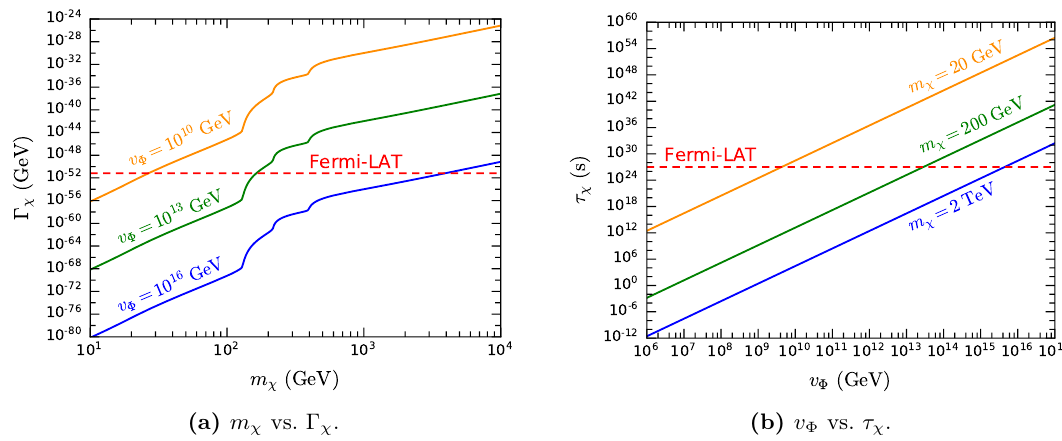
(b) v Φ vs. τ χ . Figure 3. χ decay width Γ χ as functions of m χ for v Φ = 10 10 , 10 13 , and 10 15 GeV (a) and χ lifetime τ as functions of v for m = 20 , 200 , and 2000 GeV (b). Other parameters are fixed as χ Φ χ = 300 GeV , m = m = 0 . 1 v , λ = 0 . 03 , λ = λ = 0 . 01 , and sin ε = 0 . 1 . v S = 1 TeV , m h h 3 Z 0 Φ HS H Φ S Φ 2 The dashed lines denote the conservative constraint τ & 10 27 s from Fermi-LAT γ -ray observations χ of dwarf galaxies